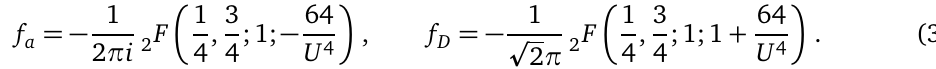
Figure 15: Possible choices of branch cuts for the physical periods a for the E theory with λ = − 1